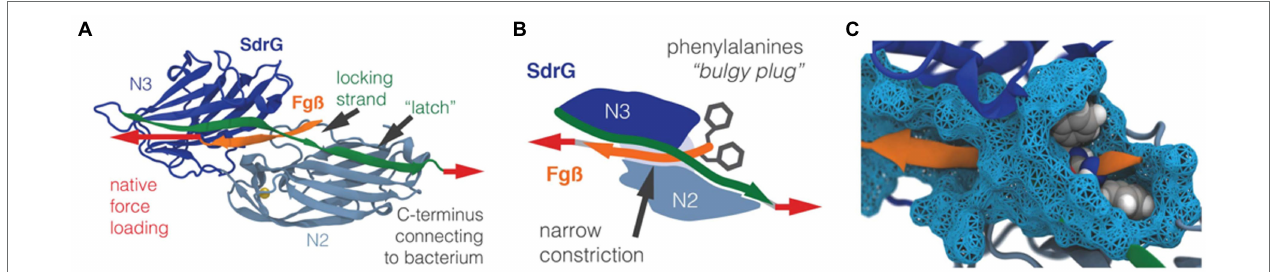
FIGURE 9 | Structure of the SdrG-Fg β complex. (A) The crystal structure of the SdrG (blue): Fg β (orange) complex. The locking strand (green) encloses the peptide in the binding pocket between the Ig-fold N2 (light blue) and N3 (dark blue) domains and a calcium (yellow) binding loop. The red arrows indicate the force applied to the molecular complex. (B) Schematic of the “bulgy plug” hypothesis. The bulky phenylalanine side chains (gray) of Fg β (orange) are blocked by the locking strand (green). (C) Crystal structure showing the bulky phenylalanine side chains in van der Waals representation (gray spheres) of Fg β (orange), which have to wiggle through a narrow constriction (cyan surface). This figure is adapted with permission from Milles et al.